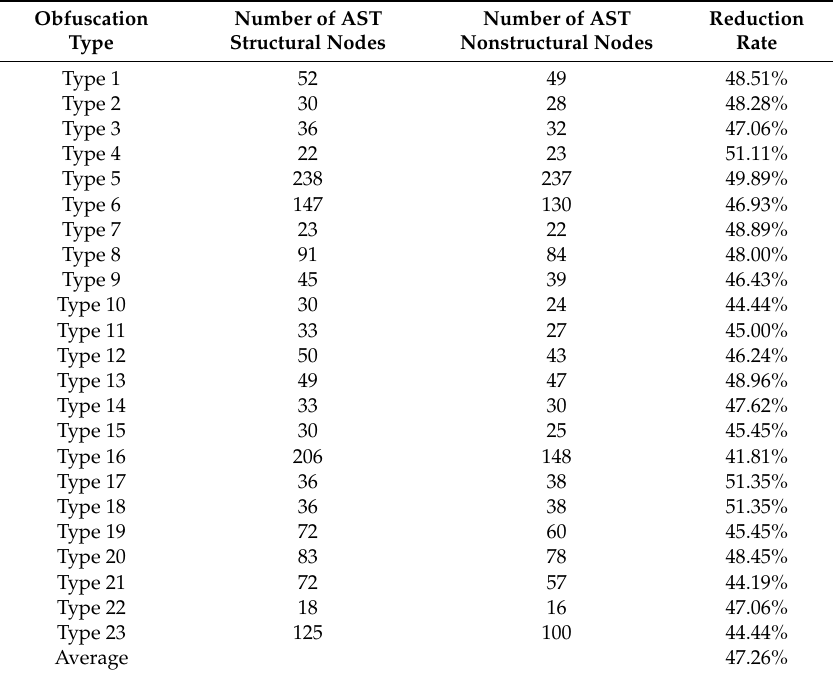
Table 4. Practical minimum node reduction rate according to obfuscation